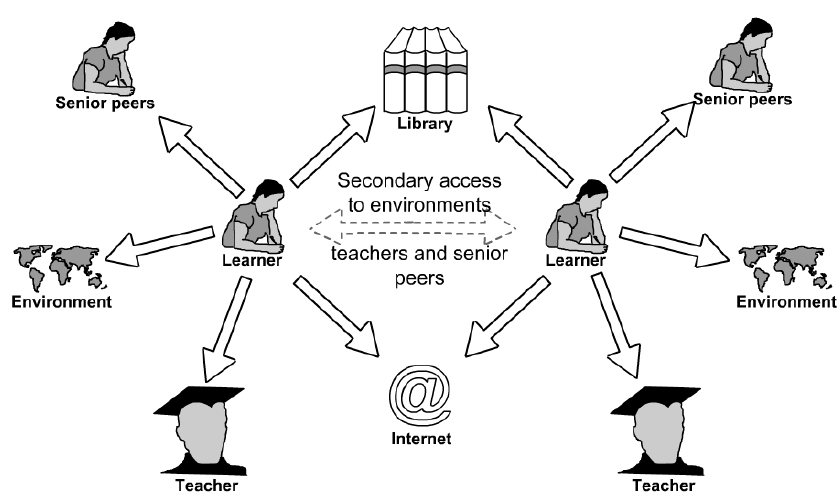
Figure 3 . The learner centered collaborative